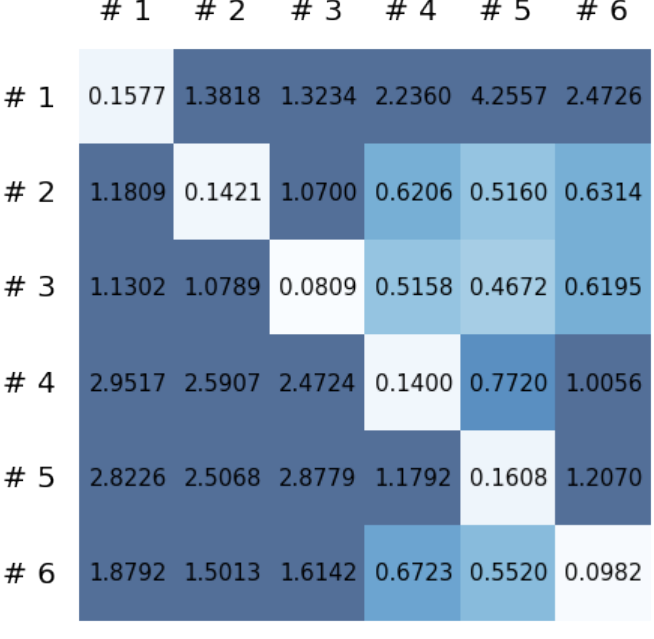
Figure 9. Mean squared error values of the FNO model for each subject for walking